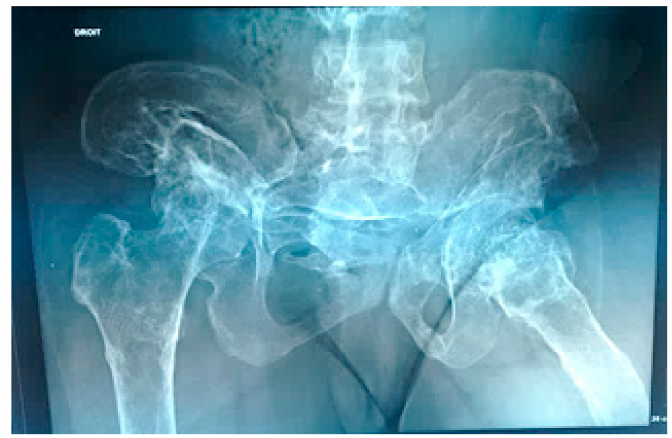
Figure 4. Anteroposterior pelvis radiograph showed severe osteolytic involvement of the hips associated with massive disorganization / distortion of the weight bearing components with subsequent development of lower limb length inequality. The patient was able to walk a few days after surgery using crutches with partial weight bearing. Osteogenesis imperfecta was the first proposed diagnosis because of long bone fracture and osteopenia. Next-generation sequencing panel to detect COL1A1 / 2 mutations was negative.